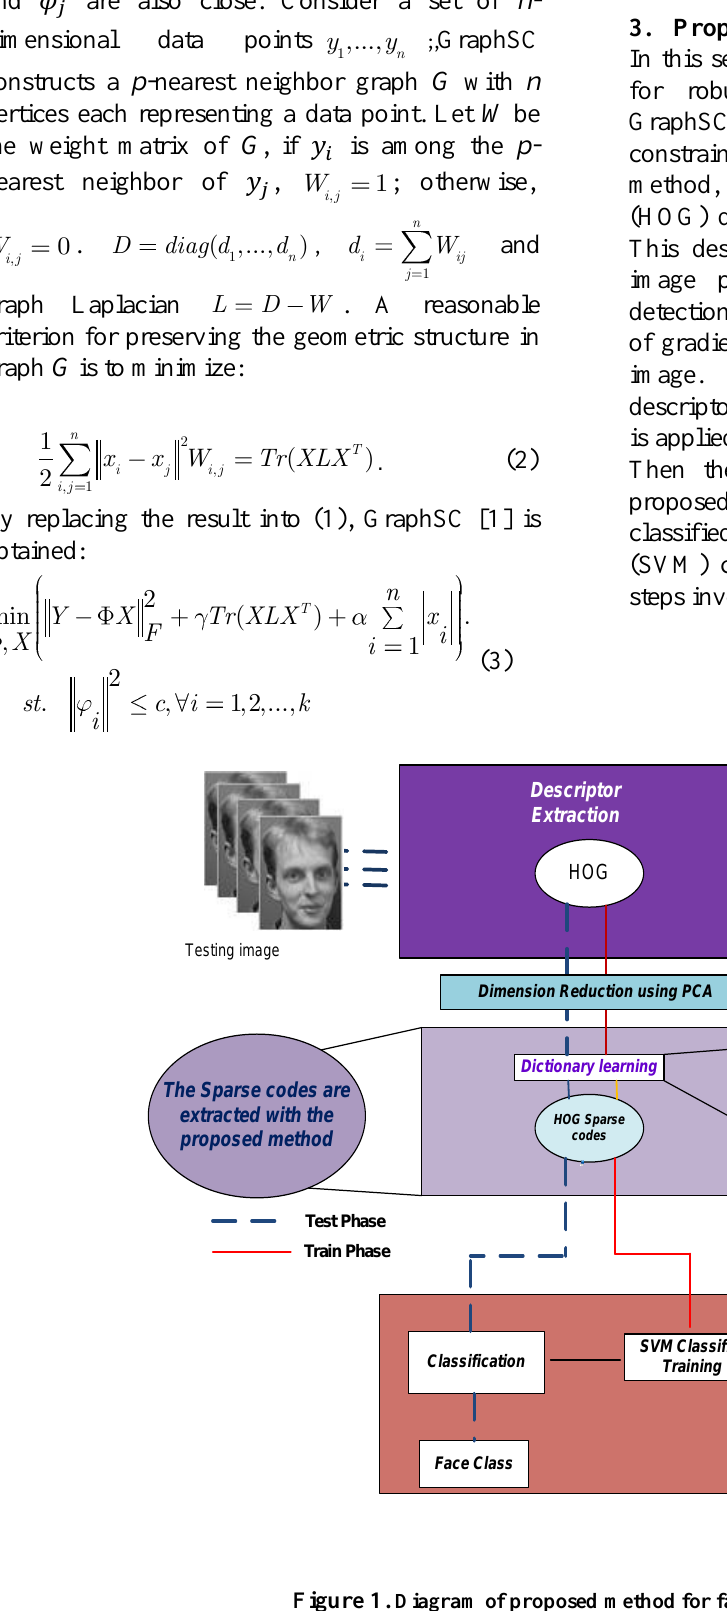
Figure 1. Diagram of proposed method for face